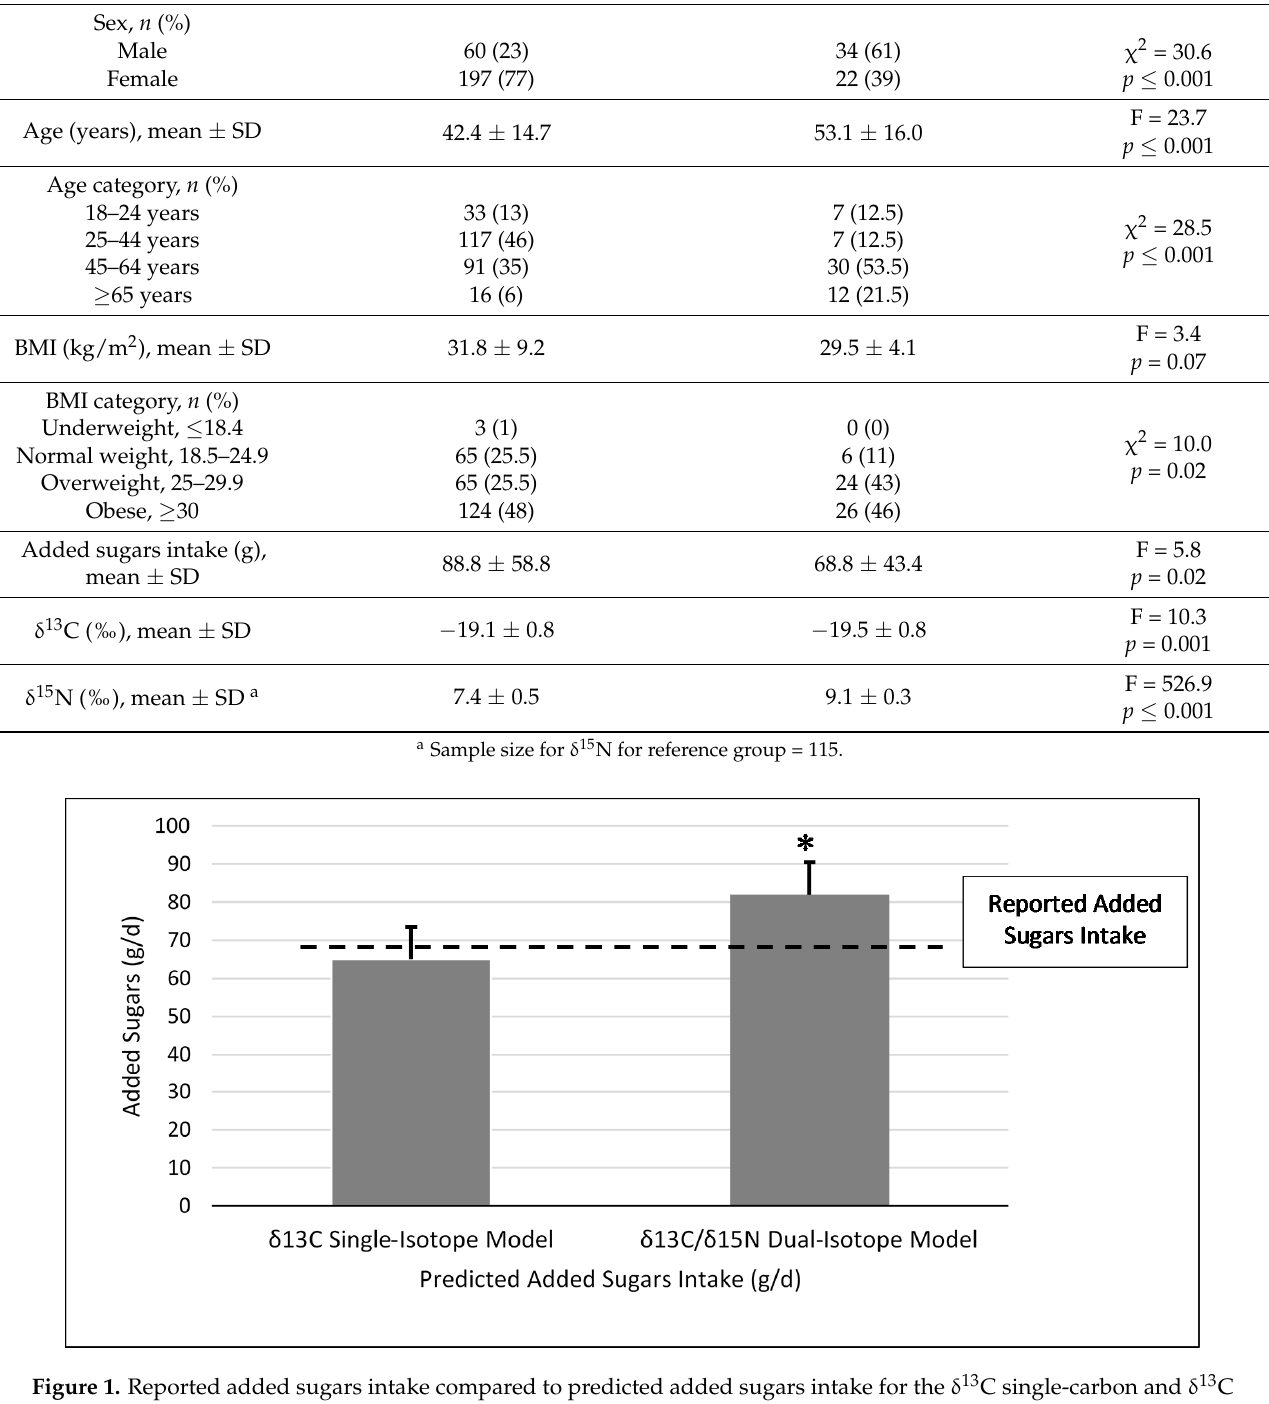
Figure 2. Bland–Altman analysis of reported and predicted added sugars intake (g) using a δ 13 C single-carbon stable isotope ratio prediction model in the test group ( n = 56) . * The center line rep- resents the mean difference, and the upper and lower lines indicate the mean ± 1.96 standard devi- ation. 3.3. Dual-Isotope Equation When applying the δ 13 C and δ 15 N dual-isotope equation to the test group, predicted AS was significantly greater than reported AS intake (mean difference ± SEM = 13.0 ± 5.4 g, Z = − 2.95, p = 0.003) (Figure 1), and the correlation was similar to the single-isotope